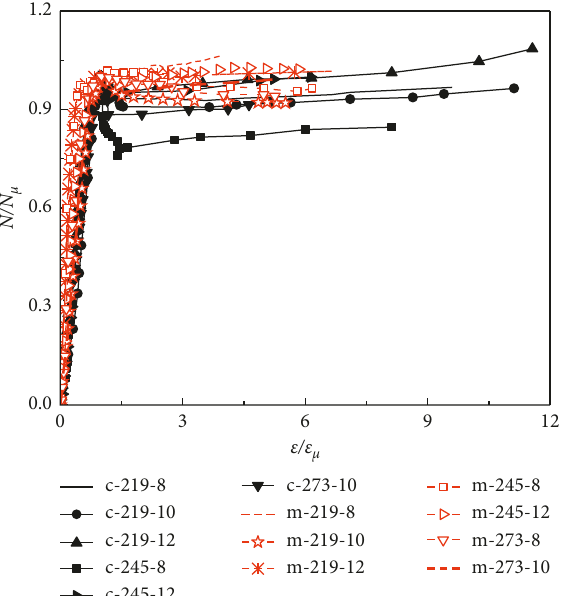
Figure 6: Comparison of envelope curves and unitary envelope curves of RFCT